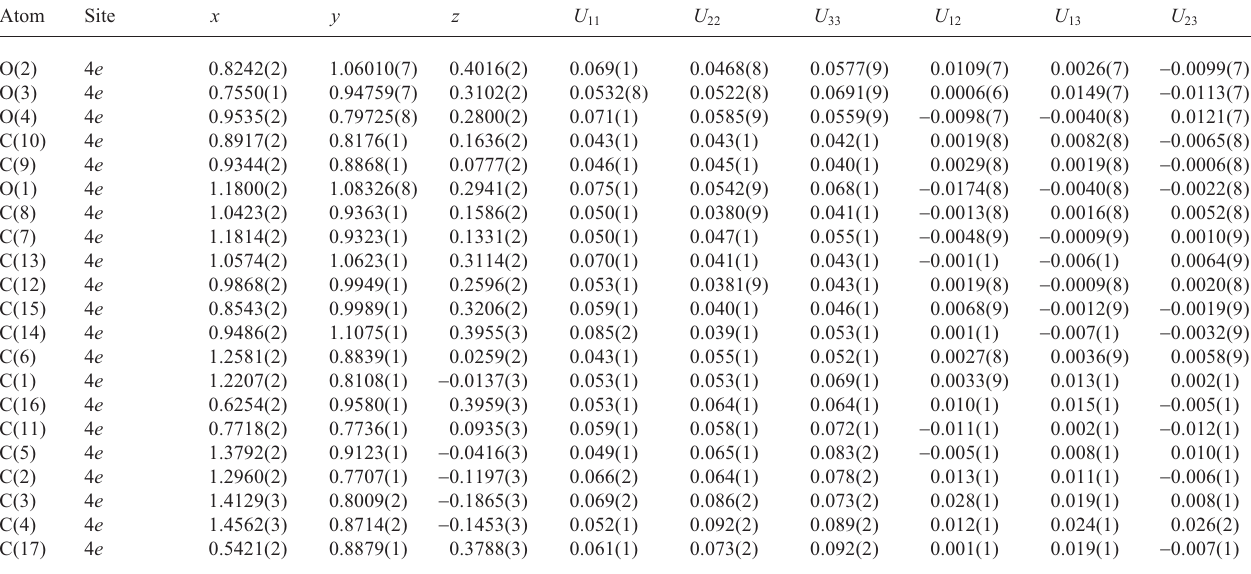
Table 3. Atomic coordinates and displacement parameters (in Å 2 )